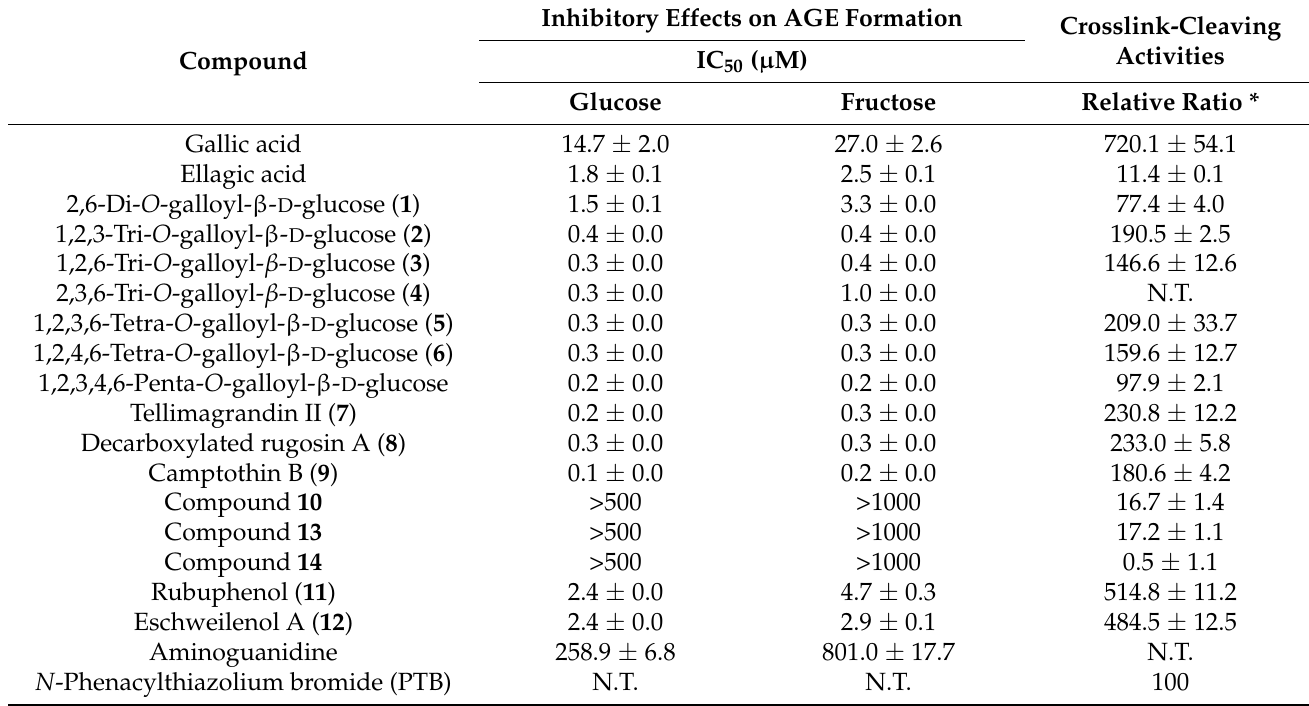
Table 2. AGE-formation inhibitory effects in HSA/glucose or fructose and AGE-derived crosslink-cleaving activities of polyphenols isolated from TBE and related